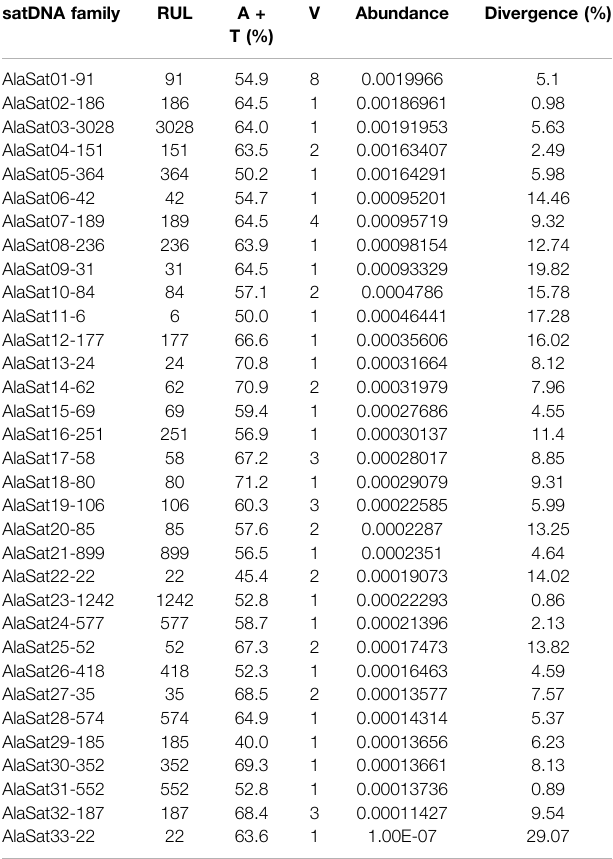
TABLE 3 | Main characteristics of Astyanax lacustris satellitome. TABLE 4 | Superfamilies characterized in satellitomes of Psalidodon fasciatus , Psalidodon bockmanni, and Astyanax lacustris